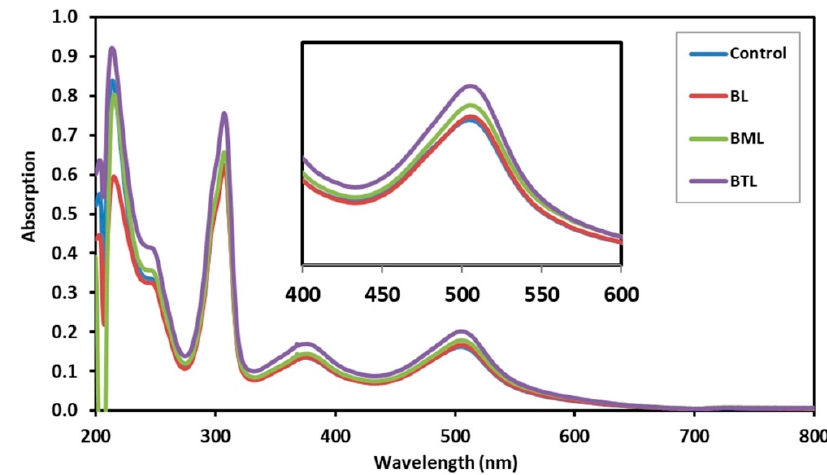
Figure 6. UV–Vis analysis of the desorbed dye solution of untreated (control) and TiCl 4 -treated (bottom layer-BL, bottom & middle layer-BML, and bottom & top layer-BTL) samples.